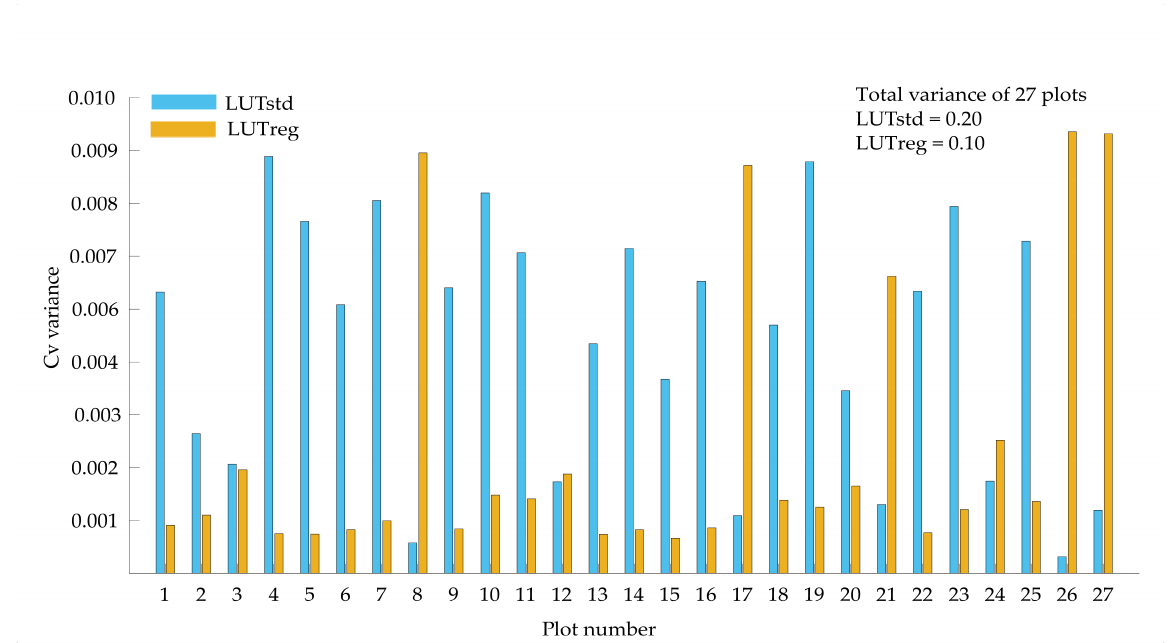
Figure 8. The magnitude of Cv variation across 27 potato plots obtained from both types of